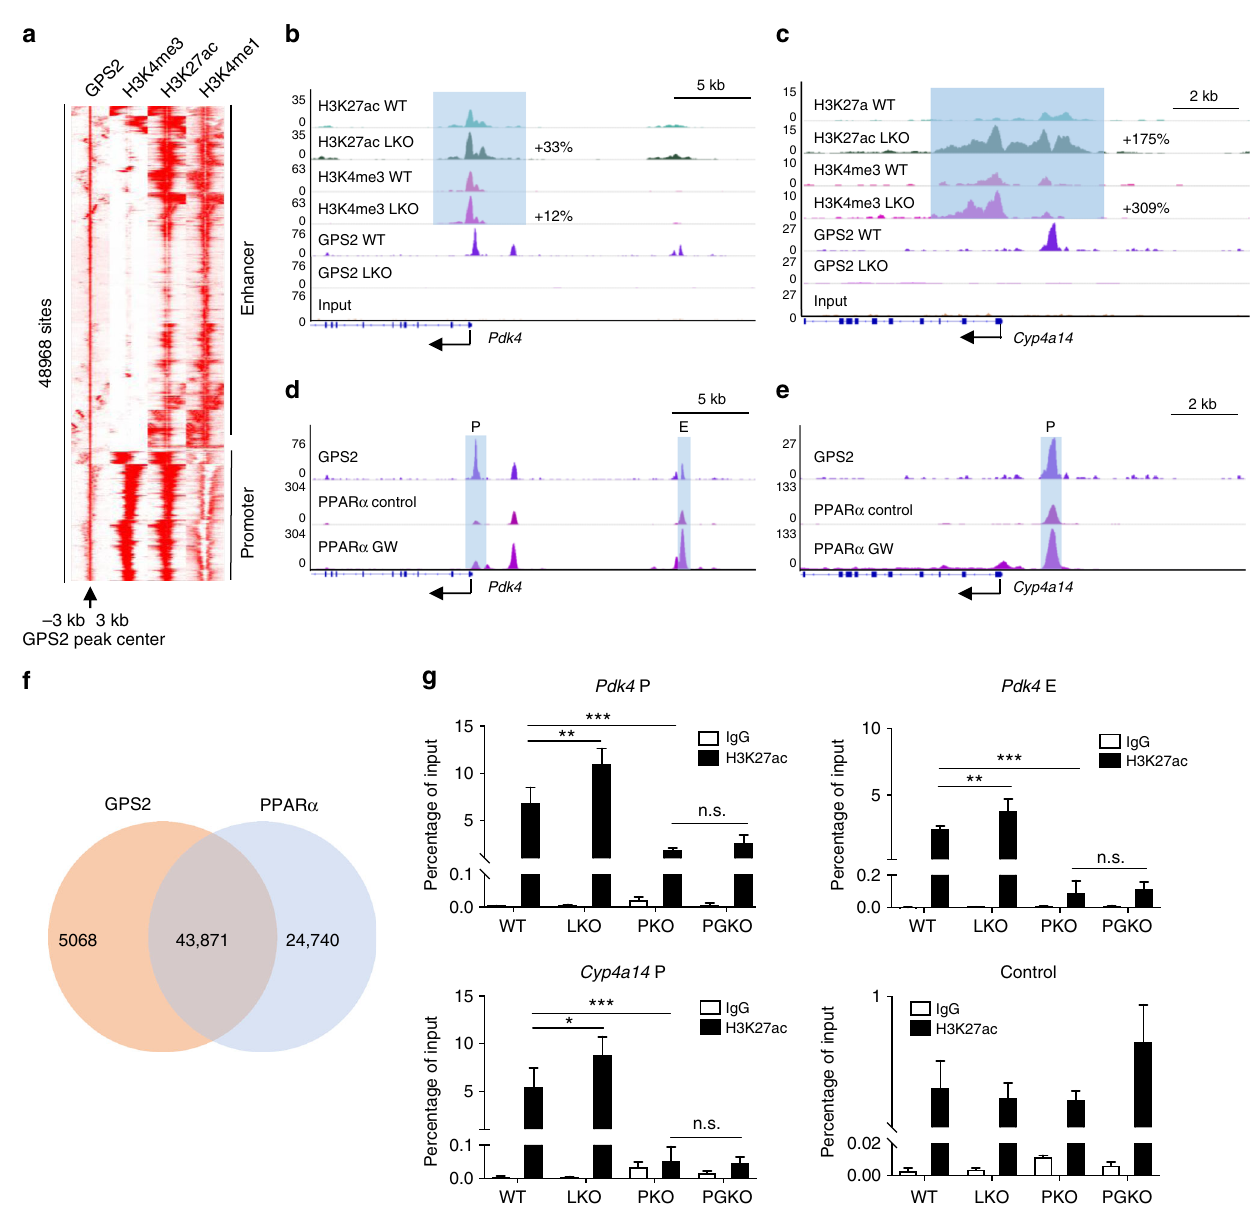
Fig. 4 GPS2 represses PPAR α -regulated promoters and enhancers. a GPS2, H3K4me3, H3K27ac, and H3K4me1 ChIP-seq peaks are aligned to the GPS2 peak center in a window of ±3 kb. b , c ChIP-seq tracks of GPS2, H3K27ac, and H3K4me3 peaks at ( b ) Pdk4 and ( c ) Cyp4a14 loci, percentage of increase (LKO versus WT) represents logFC of each peak and is calculated from biological duplicates. d , e ChIP-seq tracks of GPS2, PPAR α (vehicle and GW7647 treated, GSE61817) peaks at ( d ) Pdk4 and ( e ) Cyp4a14 loci. f Venn diagram representing the overlapped GPS2 and PPAR α peaks detected at least twice in mouse liver. g Further ChIP qPCR validation of H3K27ac at Pdk4 promoter (upper left), Pdk4 enhancer (upper right), Cyp4a14 promoter (lower left) and control (lower right) locus in WT, LKO, PKO, and PGKO livers, n = 5 in WT and LKO groups, n = 4 in PKO group and n = 3 in PGKO group, one-way ANOVA followed by Tukey ’ s test. All data are represented as mean ± s.e.m.* P < 0.05, ** P < 0.01, *** P <